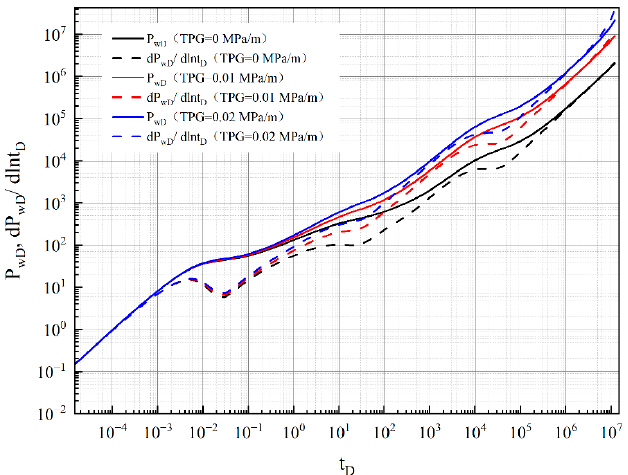
Figure 7. The effect of TPG on the pressure response.